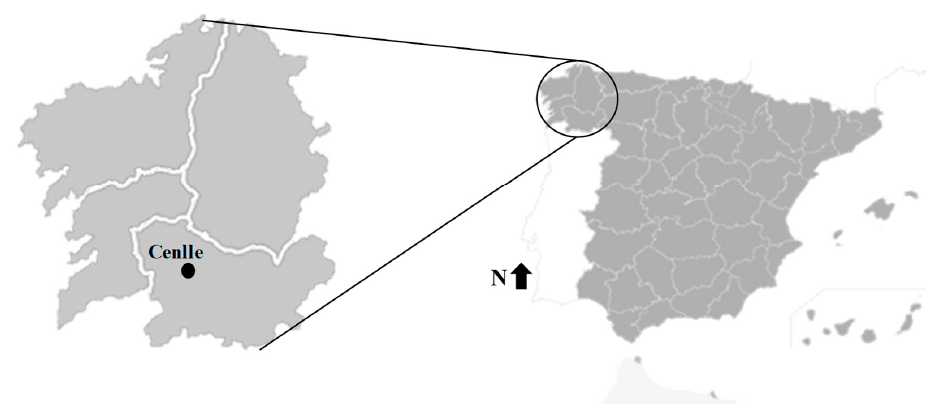
Figure 1. Location of Cenlle in